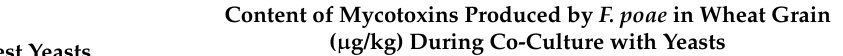
control was found in the sample with the yeast R. glutinis (E20)—108.3 µg/kg. Table 3. Mycotoxin contents in wheat grain after 14 days of incubation (28 ◦ C) of F. poae with the test